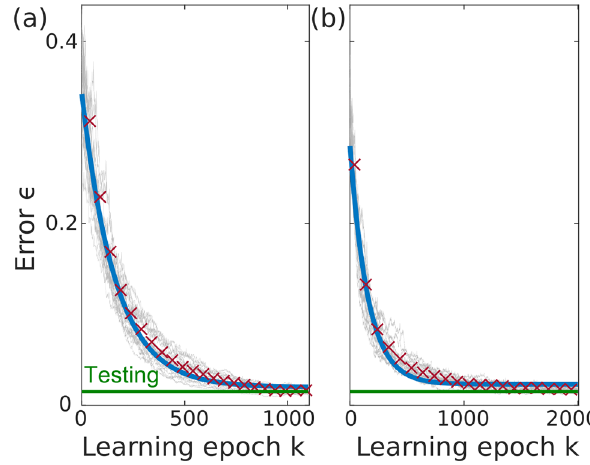
Figure 2: Learning performance, with individual (averaged) trajectories shown by grey data (red crosses). The green line is the testing error, and the blue is an exponential fit. Panel (a) and (b) wereobtainedwith